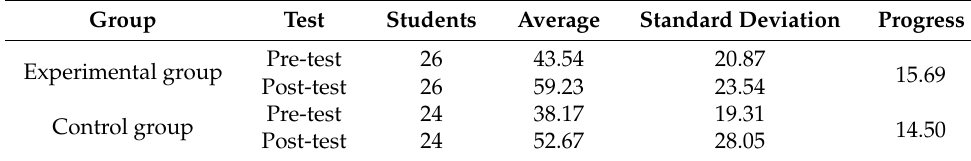
Table 2. Descriptive statistics of the pre-test and post-test scores. Group